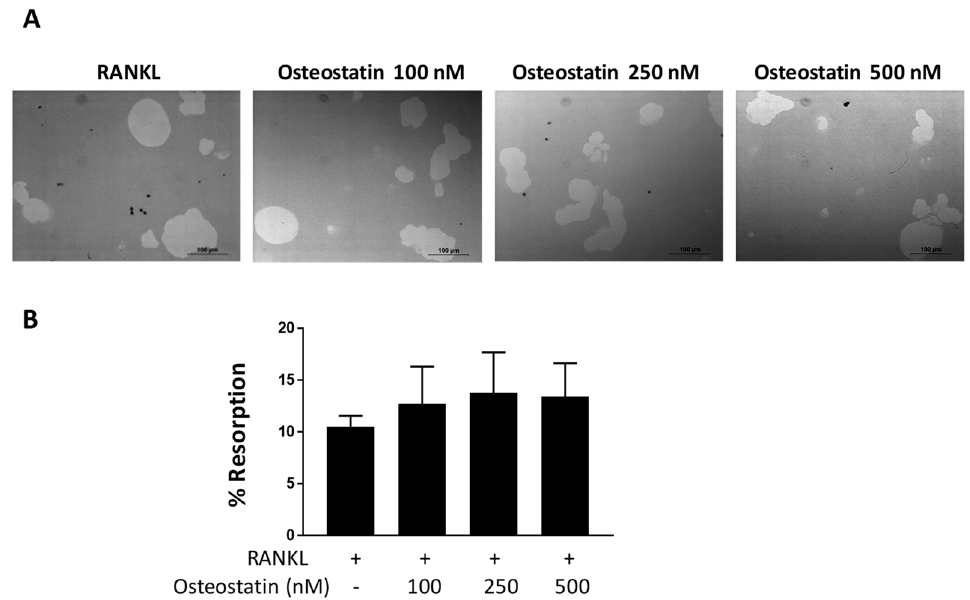
Figure 2. The effects of osteostatin on resorption. Differentiated osteoclasts were seeded on a 96-well osteoassay plate and incubated with RANKL in the presence or absence of osteostatin (final concentrations: 100, 250 and 500 nM) for 2 days. ( A ) Representative images of resorption pits; Bar = 100 µ m. ( B ) Percentage of resorption area. Values are the mean ± S.D. of four independent experi- ments.